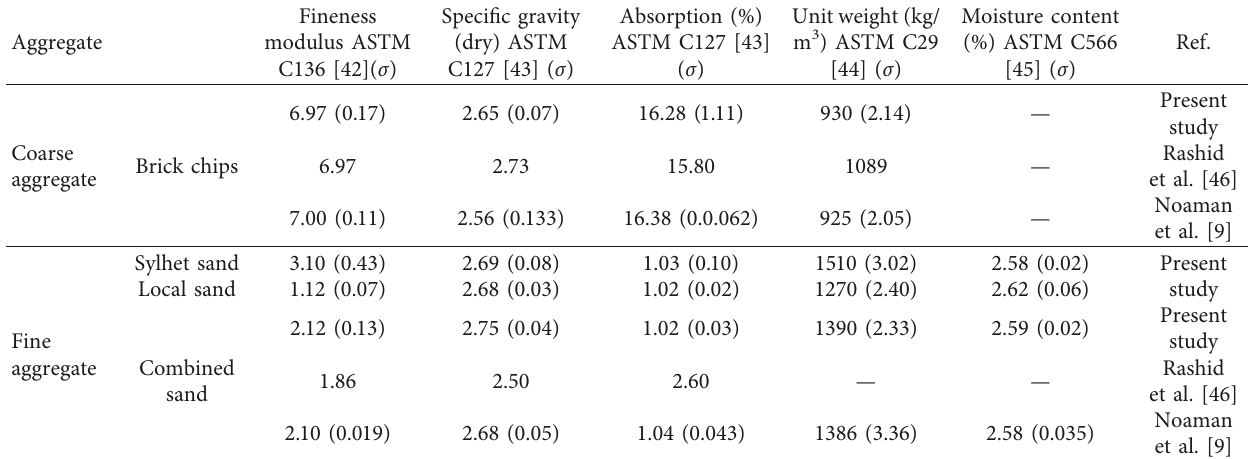
Table 1: Physical properties of coarse and fine aggregates.